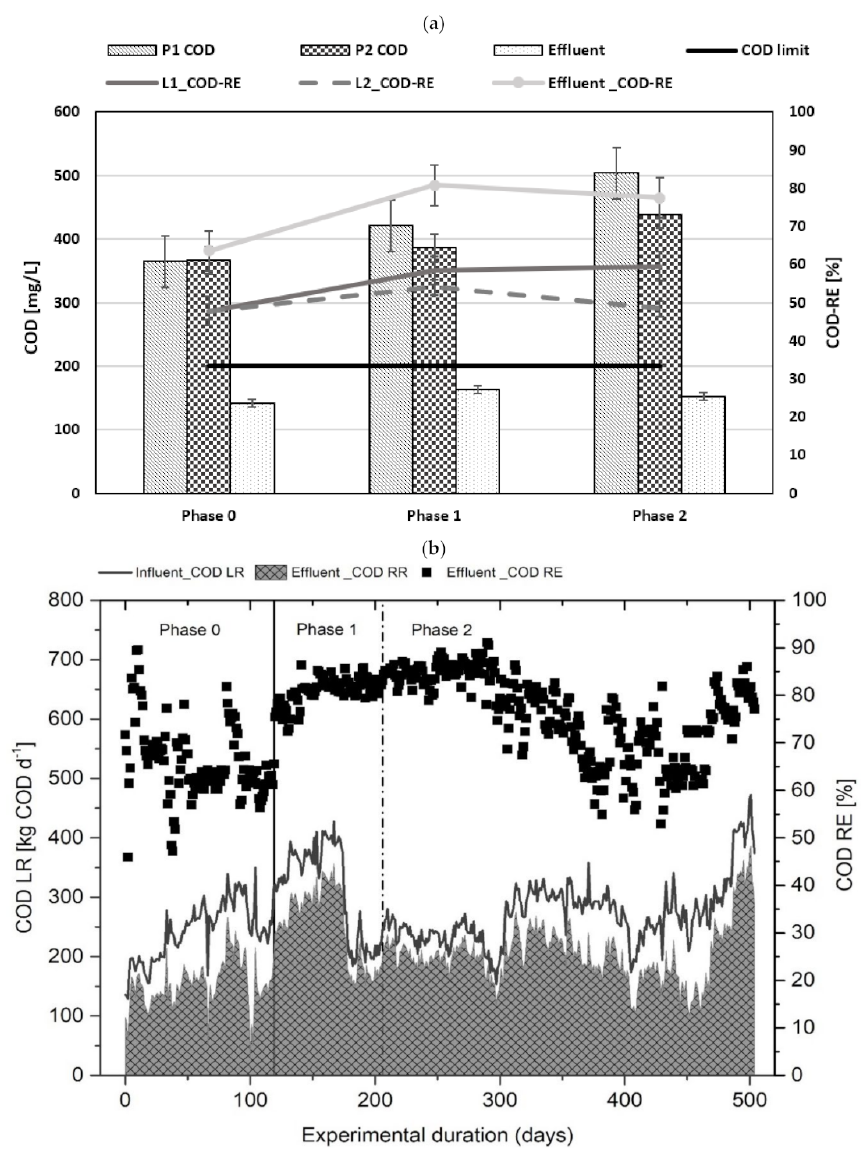
Figure 8. ( a ) COD in L-1 permeate (P1 COD), COD in L-2 permeate (P1 COD) after activated sludge and UF treatment, COD in the effluent after GAC treatment, COD limit, COD removal efficiency (COD-RE) in L-1, L-2, and effluent. ( b ) COD load rate (COD LR), COD removal rate (COD-RR), COD-RE in the effluent after GAC